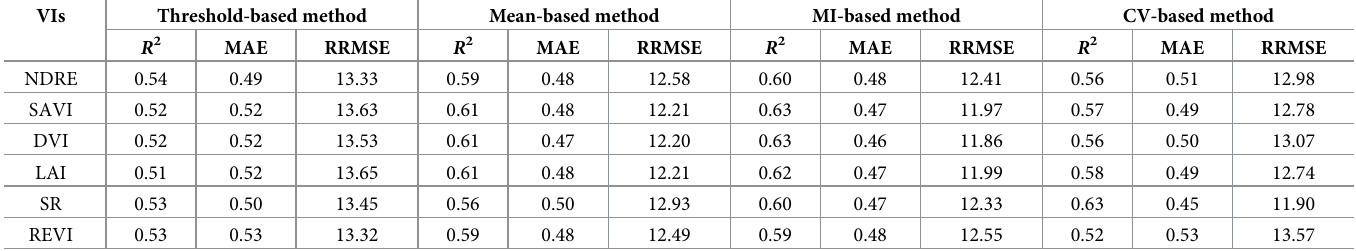
Observations with the mean-based method Since the threshold-based method required identifying the best threshold for each vegetation index to separate the healthy and disease pixels, it was difficult to find the best threshold for some vegetation indices as there was no clear separation in pixel value that segments the image into healthy and disease classes. However, the mean-based method was simple to implement and the results showed that it is more efficient than the threshold-based method as seen in Tables 3 and 4. Table 4. The performance comparison of four methods (Threshold-based, Mean-based, MI-based and CV-based) on selected six vegetation indices for UAV-derived image taken after (DAP-129) manual LLS rating. Note that the best thresholds chosen for NDRE (0.45), SAVI (0.67) and DVI (0.45), LAI (2.6), SR (27.0), RDVI (0.55), REVI (0.24) for threshold-based method. VIs Threshold-based method MAE NDRE 0.54 SAVI